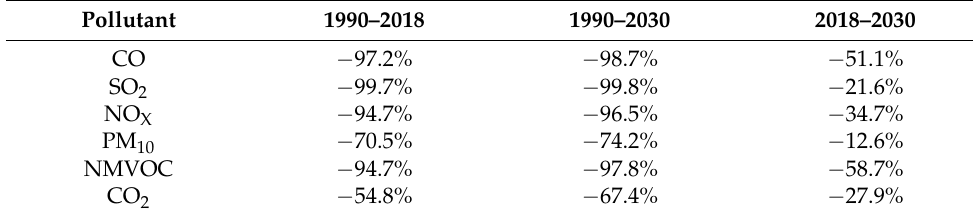
Table 1. Average total emissions reductions per vehicle.